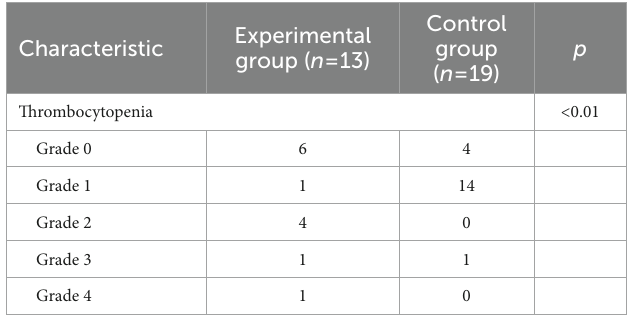
TABLE 3 The incidence of thrombocytopenia in patients with moderately well-differentiated cervical cancer between the two groups.